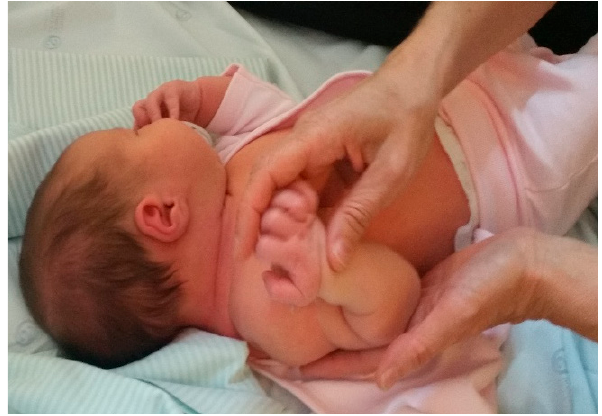
Figure 4. Passive mobilisation, elbow flexion.